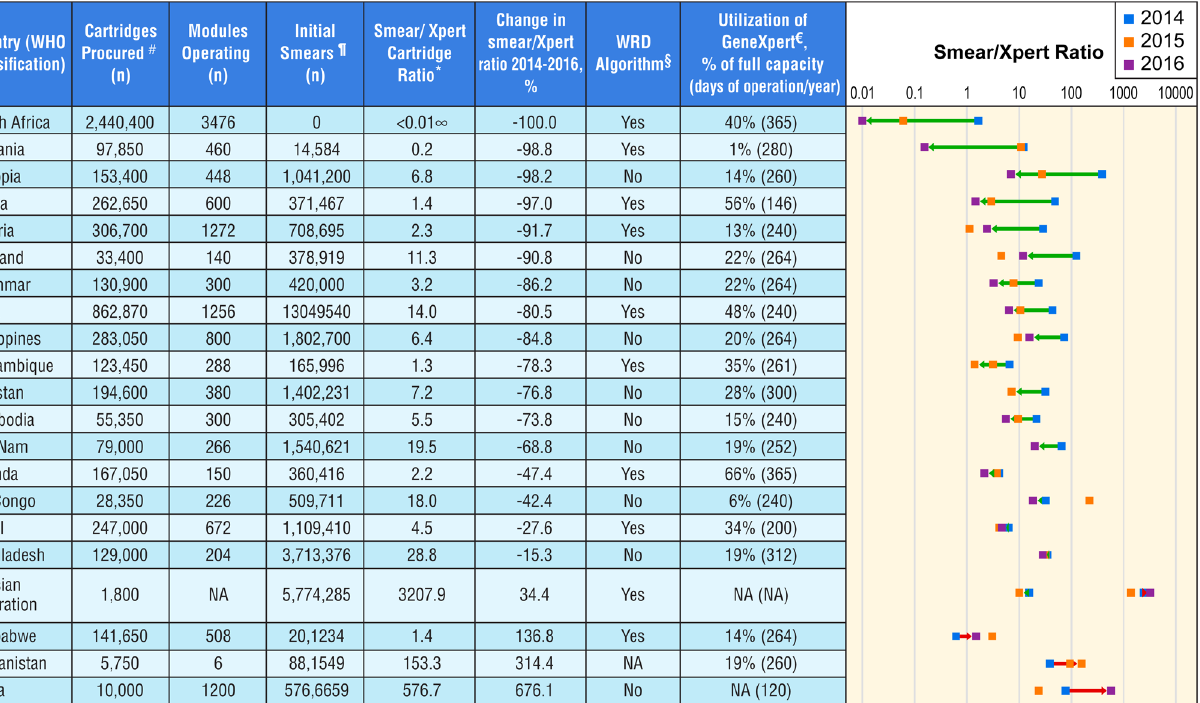
Figure 1. Xpert MTB/RIF market penetration in the public sector of 21 high TB burden countries (2014–2016). South Africa decreased its smear/Xpert ratio by 100%, therefore has achieved the highest market penetration of Xpert MTB/RIF in the public sector. Countries are listed in order of greatest percent decrease in smear/Xpert ratio from 2014–2016. Arrows represent percent changes in smear/Xpert ratios 2014–2016. Trends moving closer to 0 (ratio decreasing) signify a greater use of Xpert compared to smear microscopy for the diagnosis of TB. Trends moving away from 0 (ratio increasing) signify a greater use of smear microscopy compared to Xpert for the diagnosis of TB.